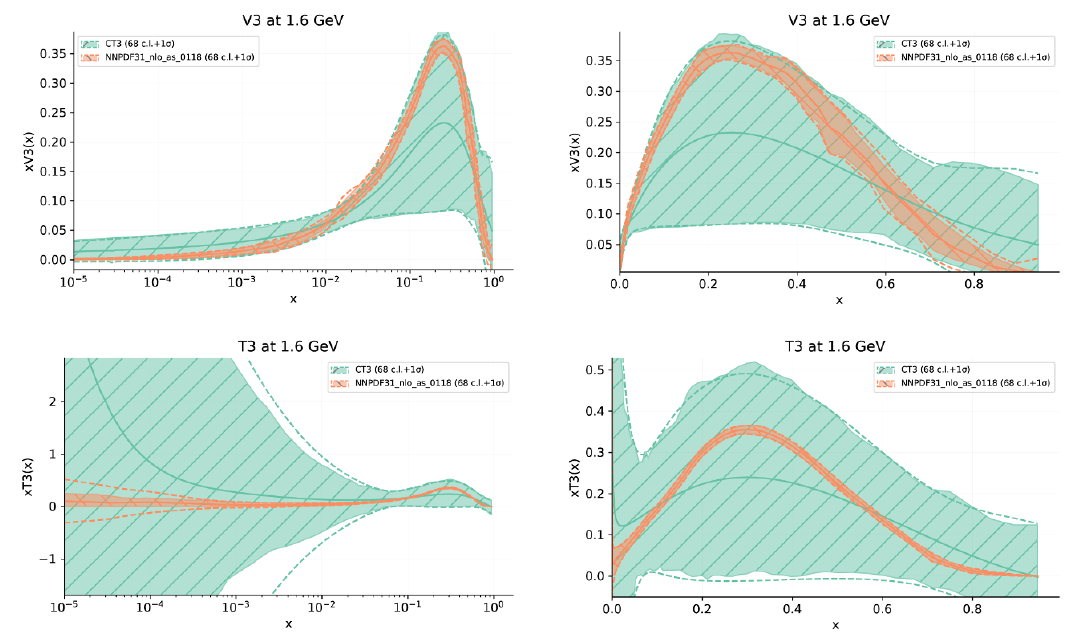
Figure 4 . Closure test (cid:12)t with real statistical and systematic error (CT3) compared to the input PDFs set. V 3 (top line) and T 3 (lower line) combinations in linear and logarithmic scale are shown. The errors of the reconstructed PDFs are huge.